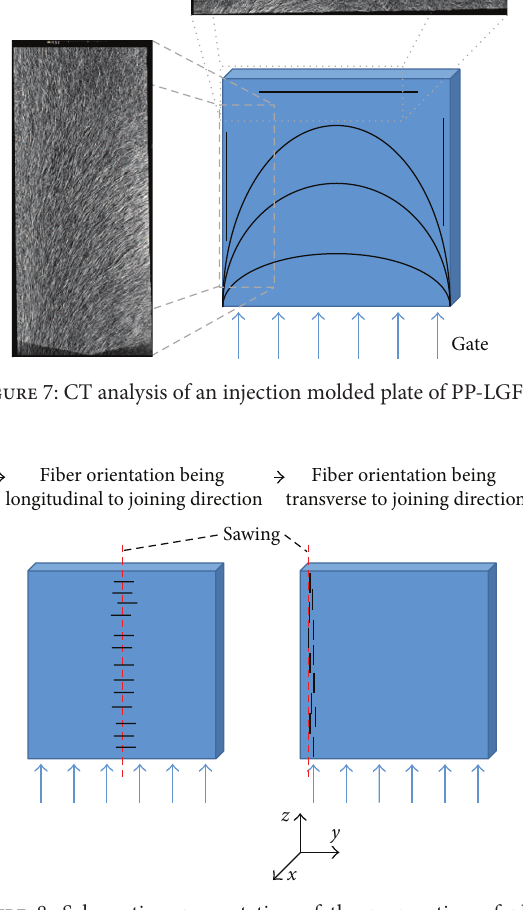
Figure 8: Schematic representation of the preparation of plates before welding.